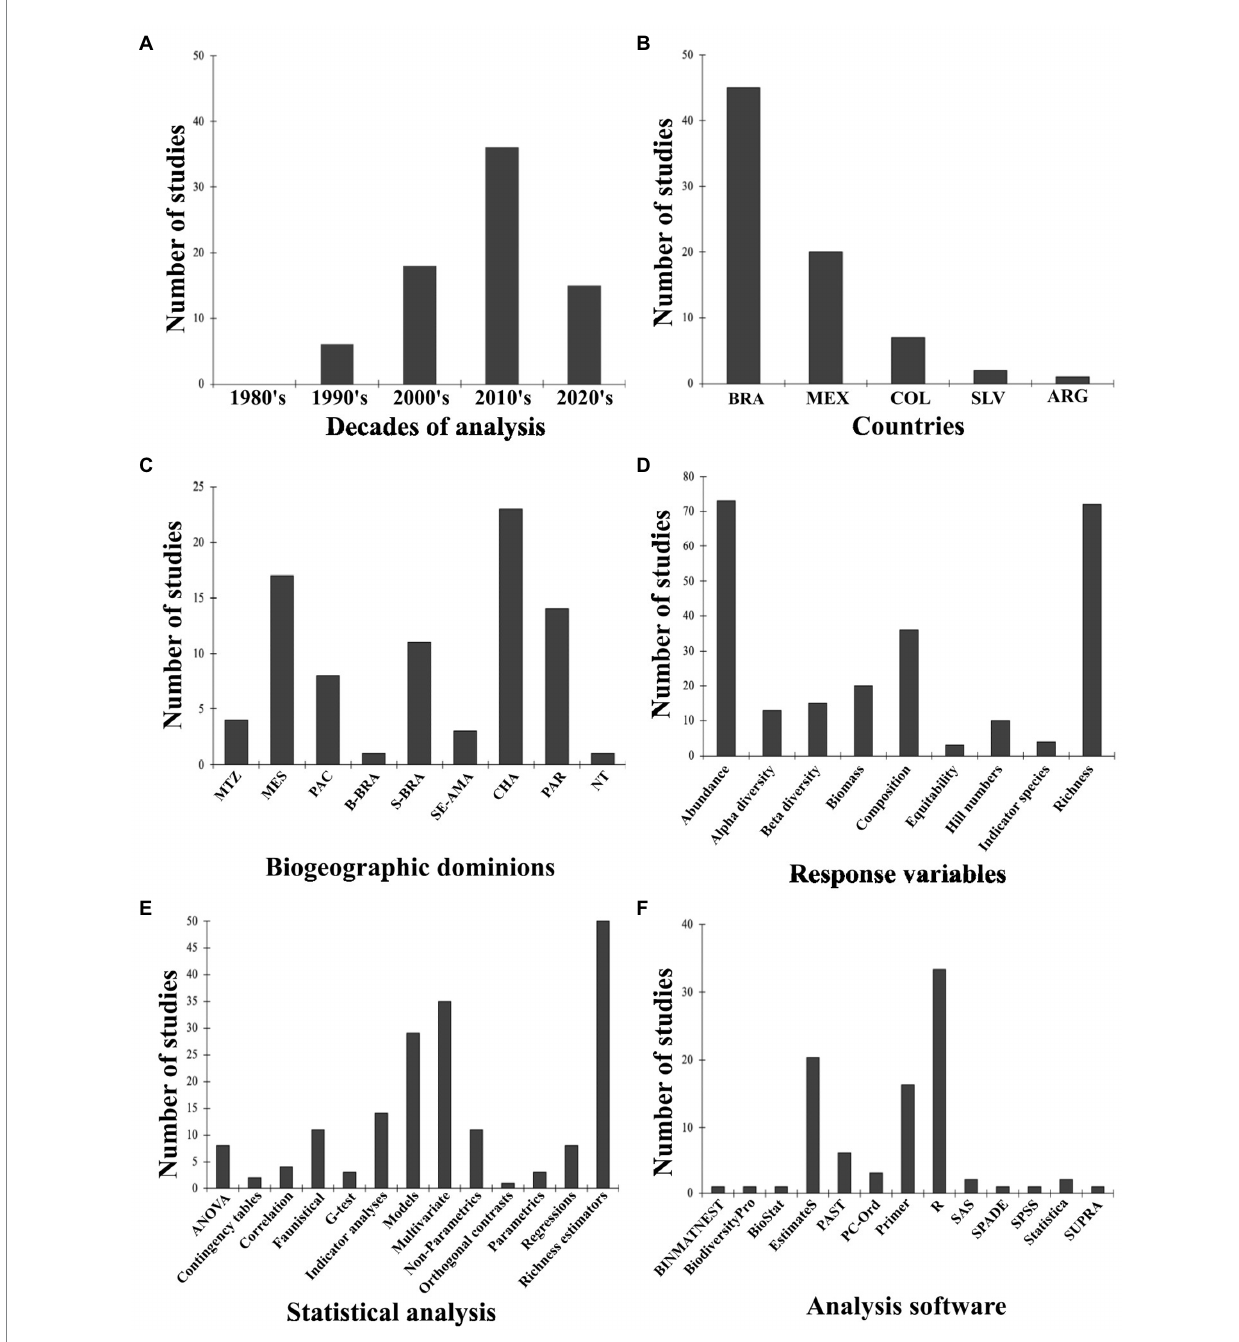
FIGURE 2 Number of taxonomic diversity studies. (A) Over time (decades). (B) Per country. Countries: Brazil = BRA, Mexico = MEX, Colombia = COL, El Salvador = SLV, Argentina = ARG. (C) Per biogeographic dominion. Mexican Tranzition Zone = MTZ, Mesoamerican = MES, Pacific = PAC, Boreal Brazilian = B-BRA, S-BRA = South Brazilian, South Eastern Amazonian = SE-AMA, Chacoan = CHA, Parana = PAR, Not tropical = NT. (D) Per response variable. (E) Per statistical analysis. (F) Per software